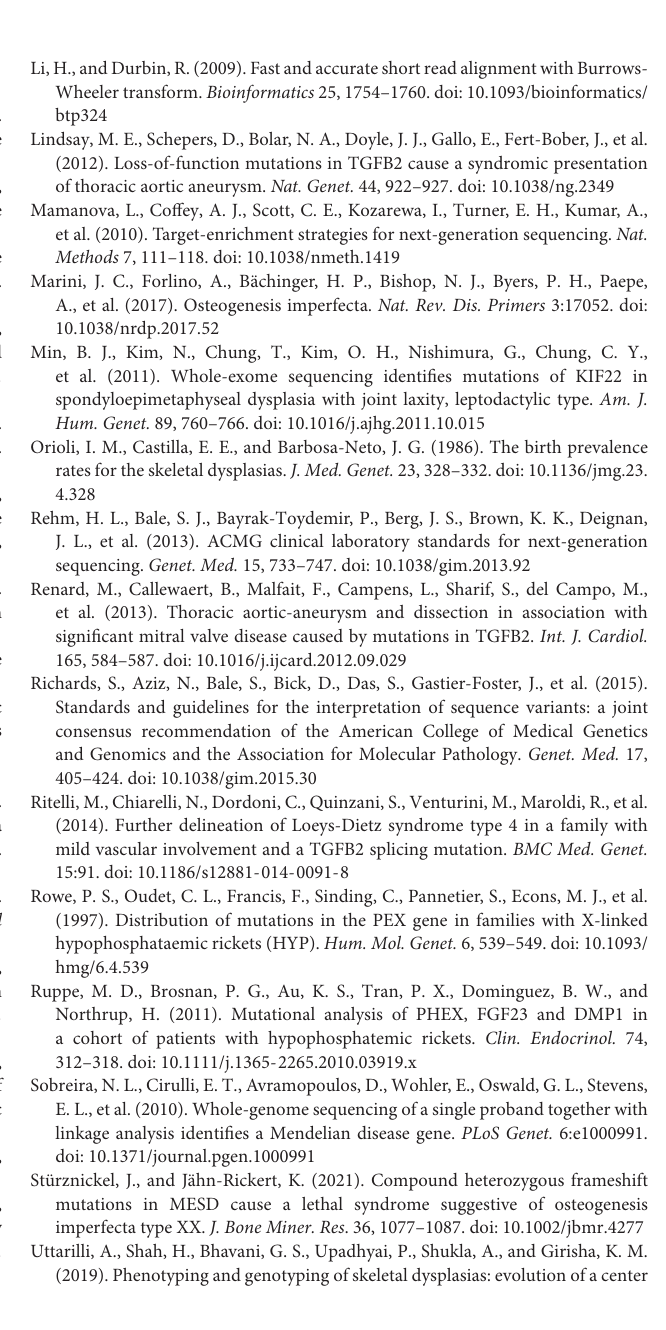
Supplementary Table 1 | Demographic characteristics and variants information of 223 probands. Supplementary Table 2 | The list of all the relevant genes in skeletal dysplasia panel. Supplementary Table 3 | Quality metrics of targeted panel